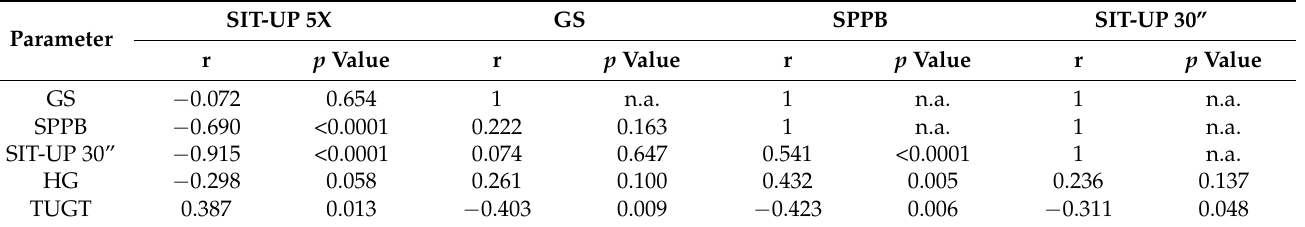
Table 2. Pearson’s coefficient correlation analysis of physical functioning tests. Significance